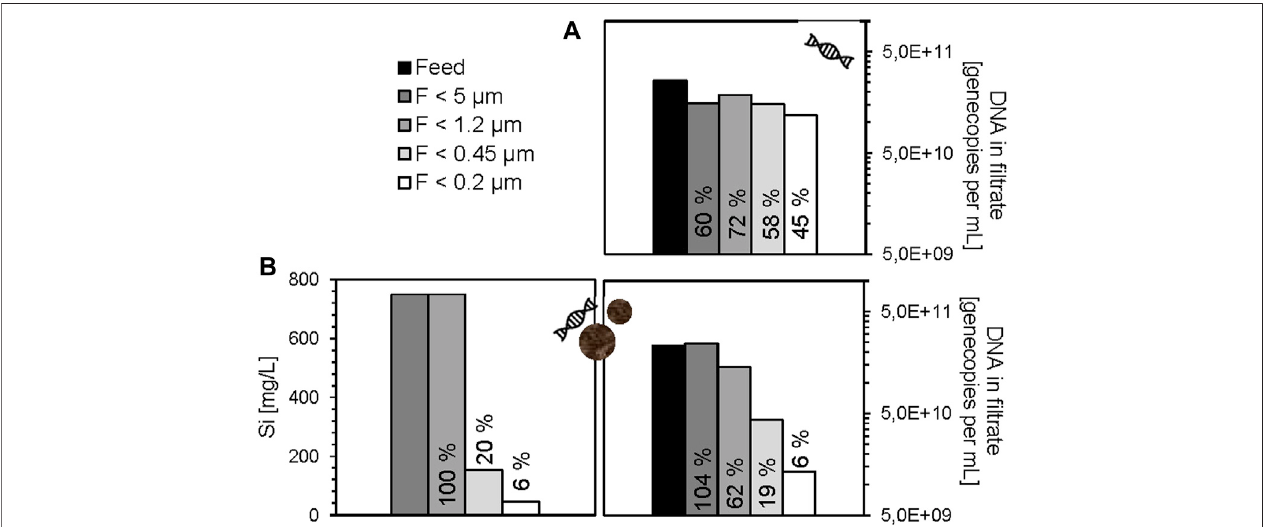
FIGURE2| FreeDNA(eARG-fragment sul2 andeDNAfragment intl1 )in fi ltratesofcascade fi ltration experiments withoutsilicaparticles (A) and withsilicaparticles (B) in ultrapure water.The percentage permeation ofeach stepwascalculated fromthe concentration ofgenecopies per mL fi ltrate divided bygenecopies per mL feed (C fi l /C feed *100).Siconcentrationisshownforthe fi ltratesoftheexperimentwithDNAandsilicaparticles;inabsenceofsilicaparticles,theSiconcentrationwasatablank level < 0.3 mg L − 1 .